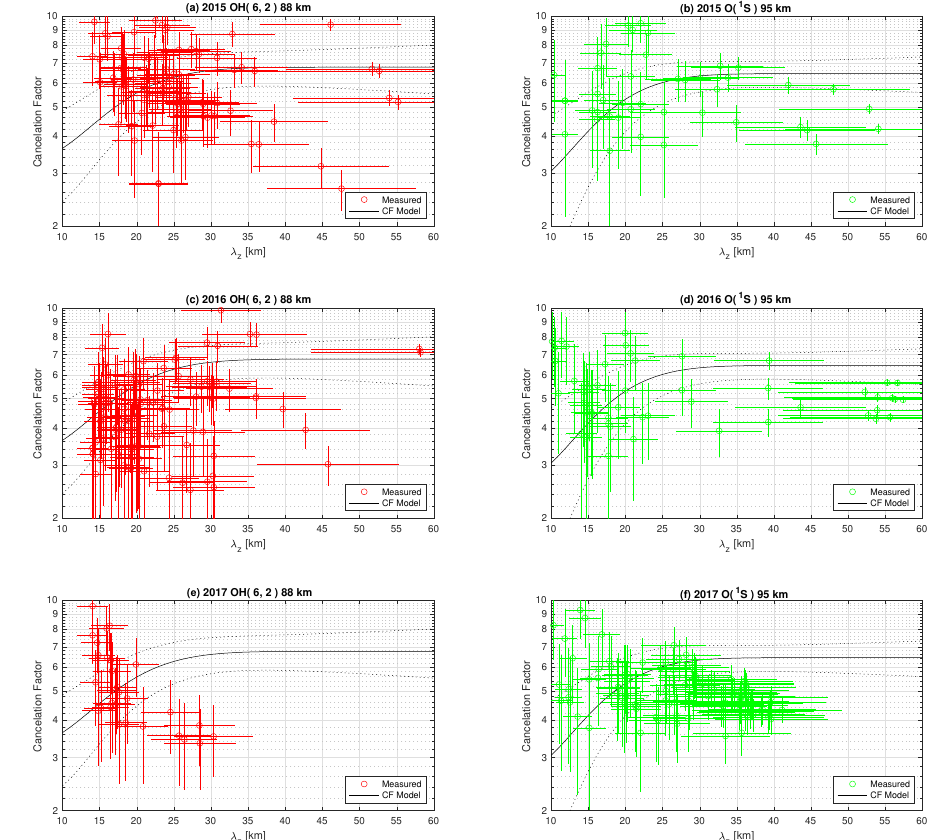
Figure 5. Observed cancellation factor corrected for both OH (red open circles) during ( a ) 2015, ( c ) 2016, and ( e ) 2017, and for O ( 1 S ) (green open circles) during ( b ) 2015, ( d ) 2016, and ( f ) 2017 along with their errors σ λ and σ CF . The dotted thin lines denote the 95% confidence bounds around the analytic z curves shown as continuous black